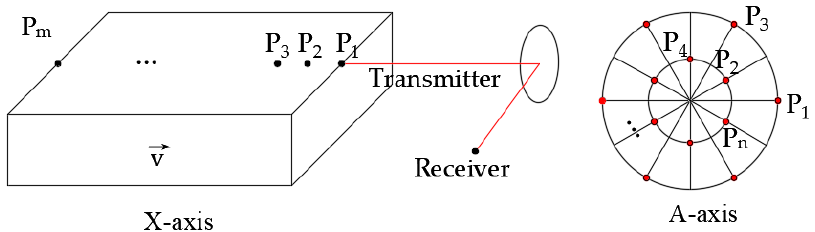
Figure 4. Measurement points on the X-axis and the A-axis.